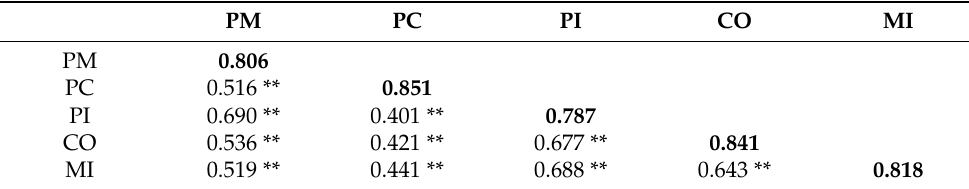
Table 4. Discriminant